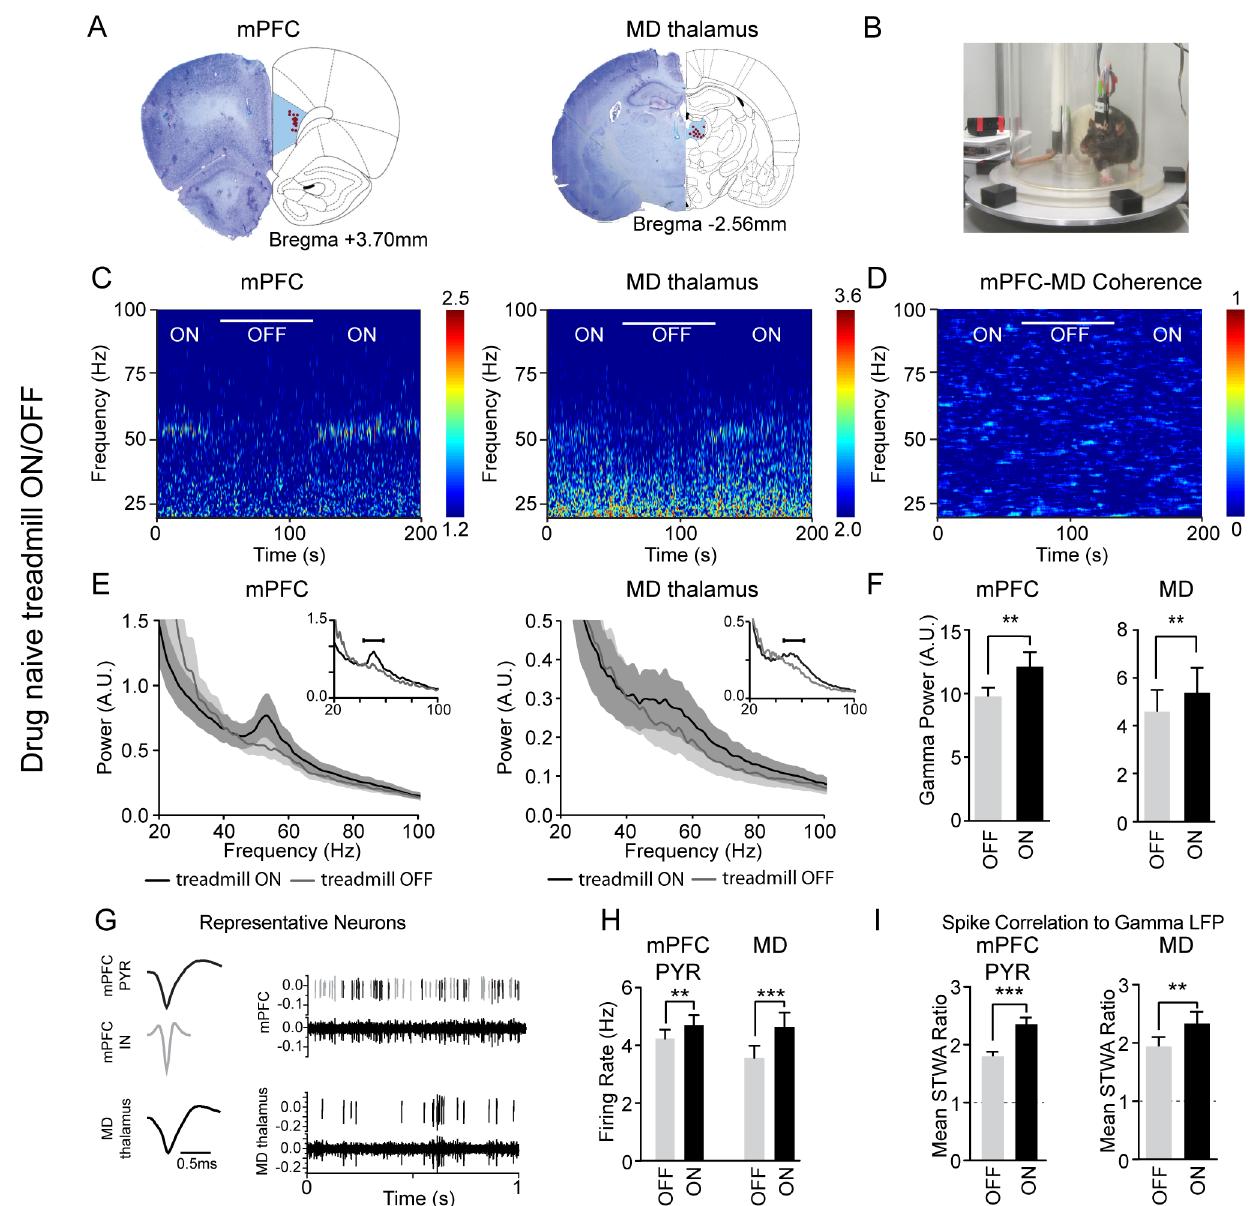
Fig 1. Walking-induced increasesin gamma power, firing rates and spike-gamma LFP correlations. A, Histologicalreconstruction showinglocations(red dots) of the recordingelectrodes in the prelimbicmPFC and MD thalamus. B, Photographshows the rotating circular treadmill. The paddlein the back ensuredthat the rat continuedwalking. C, Representative wavelet-based scalogramsshow time-frequency plots of normalized LFP spectral power duringepochs with the treadmill turned ON or OFF (white bar). Warmer colors indicatehigherpower. D, Representative FFT-based spectrogram shows time-frequency coherence betweenthe mPFC and MD thalamus. E, Average LFP power spectra ± SEM for epochs with treadmill ON (black) or OFF (grey) on day 1 of recording(n = 12 rats). Insets show representative traces for each structure. F, Bar graphs shows mean total gamma LFP power with the treadmill ON and OFF from day 1 of recording(n = 12 rats). The gamma frequency range was determined using the 15 Hz surroundingthe significantgamma peak (see Methods)between40 and 70 Hz in each treadmill walkingepoch. G, Representative pyramidal neuron(PYR, black) and interneuron (IN, grey) waveforms, raw signalsand spike trains from the mPFC and MD thalamusduringtreadmill walking. H , Firing rates in the mPFC of PYR neurons(n = 118 neuronsfrom 12 rats), and from MD thalamusneurons(n = 62 neuronsfrom 12 rats). I, Mean ratios betweenpeak-to-trough amplitudes of the originalspike-triggeredwaveform average(STWA) and the mean of 20 shuffled STWAs for LFPs filtered from 40–70 Hz recordedfrom a neighboring wire (see Methods). A ratio of 1 (dashedhorizontal line) indicatesno difference betweenshuffled and unshuffledvalues. Valuesare reportedas mean ± SEM. * : p < 0.05, ** : p < 0.01, *** : p < 0.001, bootstraptests.